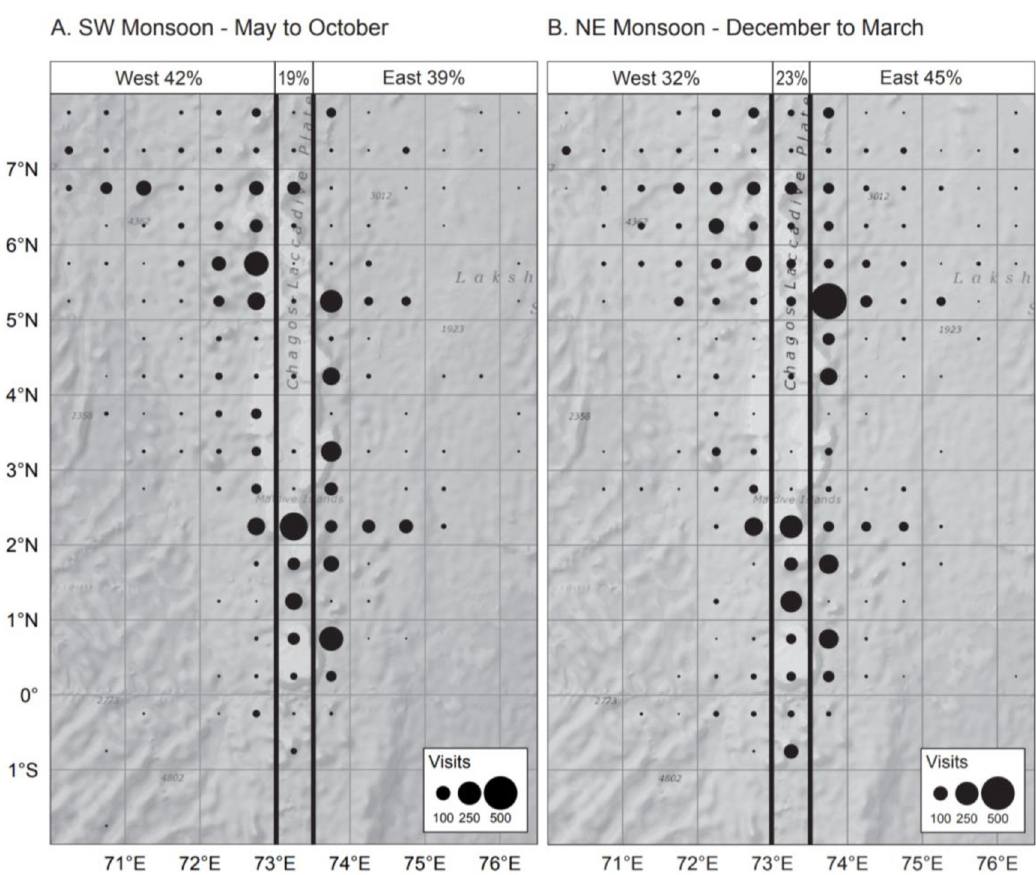
Fig 3. Mid-day position of pole-line-fishing vessels from logbook data for the SW and the NE monsoon periods for the west (70˚E to 73˚E), central (73˚E to 73.5˚E) and east (73.5˚E to 76.5˚E)